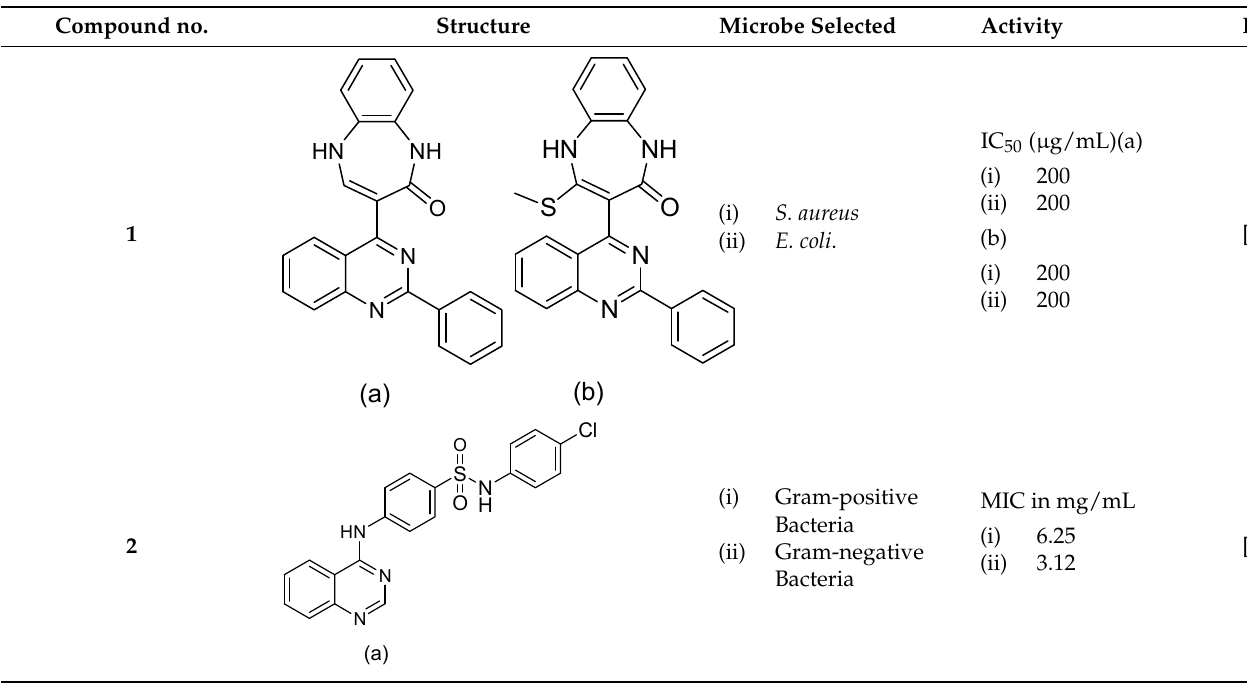
Table 4. Antibacterial activity of quinazoline derivatives.